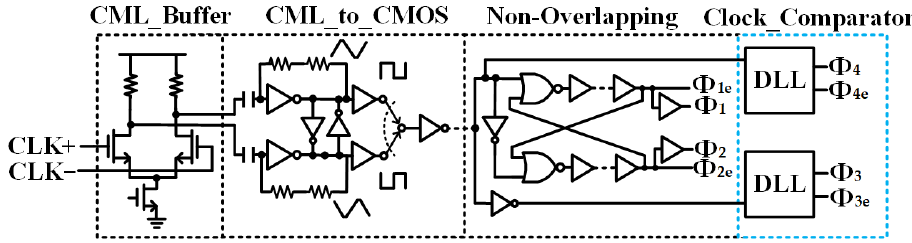
Figure 4. Clock schematic, including current mode logic, CML to the CMOS logic voltage, and non- overlapping with the outputs Ф 1 , Ф 1e , Ф 2 , and Ф 2e . DLL is added to generate Ф 3 , Ф 3e , Ф 4 , and Ф 4e . non-overlapping with the outputs φ 1 , φ 1e , φ 2 , and φ 2e . DLL is added to generate φ 3 , φ 3e , φ 4 , and φ 4e